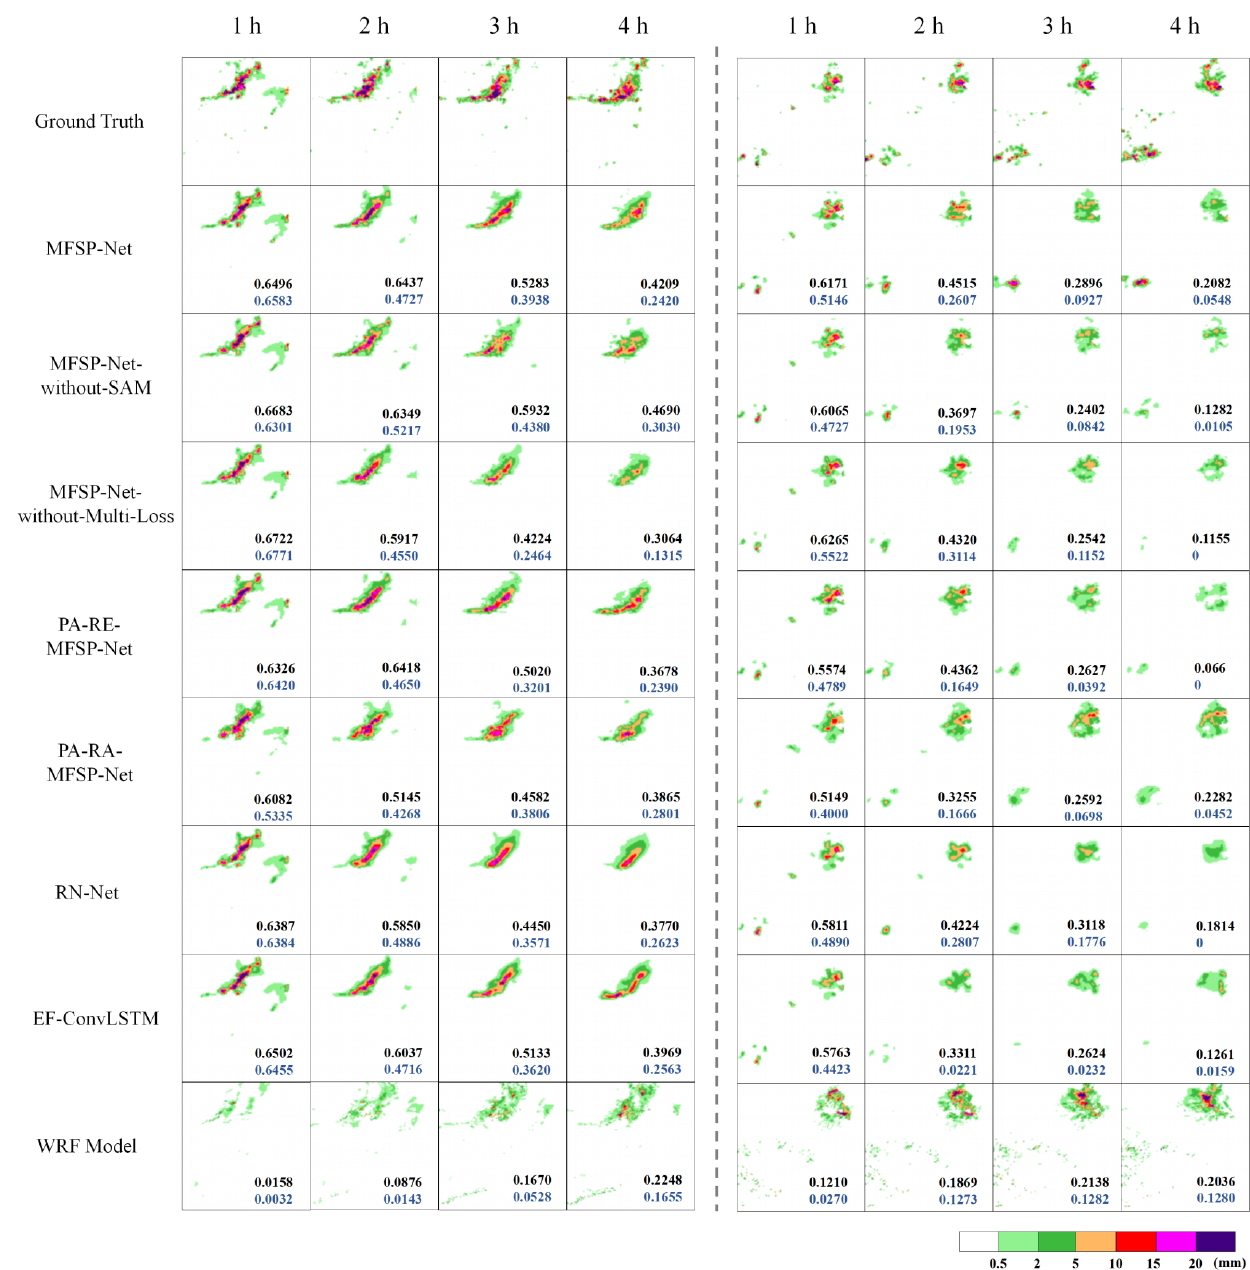
Figure 7. Visualization of two representative precipitation amount nowcasting cases. From top to bottom are the four frames’ truth precipitation amount grid data of the next four hours and precipitation amount nowcasting conducted by MFSP-Net, MFSP-Net-without-SAM, MFSP-Net-without- Multi - Loss , PA-RE-MFSP-Net, PA-RA-MFSP-Net, RN-Net, EF-ConvLSTM, and WRF models. The black value and blue value in each nowcasting frame are the CSI with 2 mm and 5 mm as the threshold for this